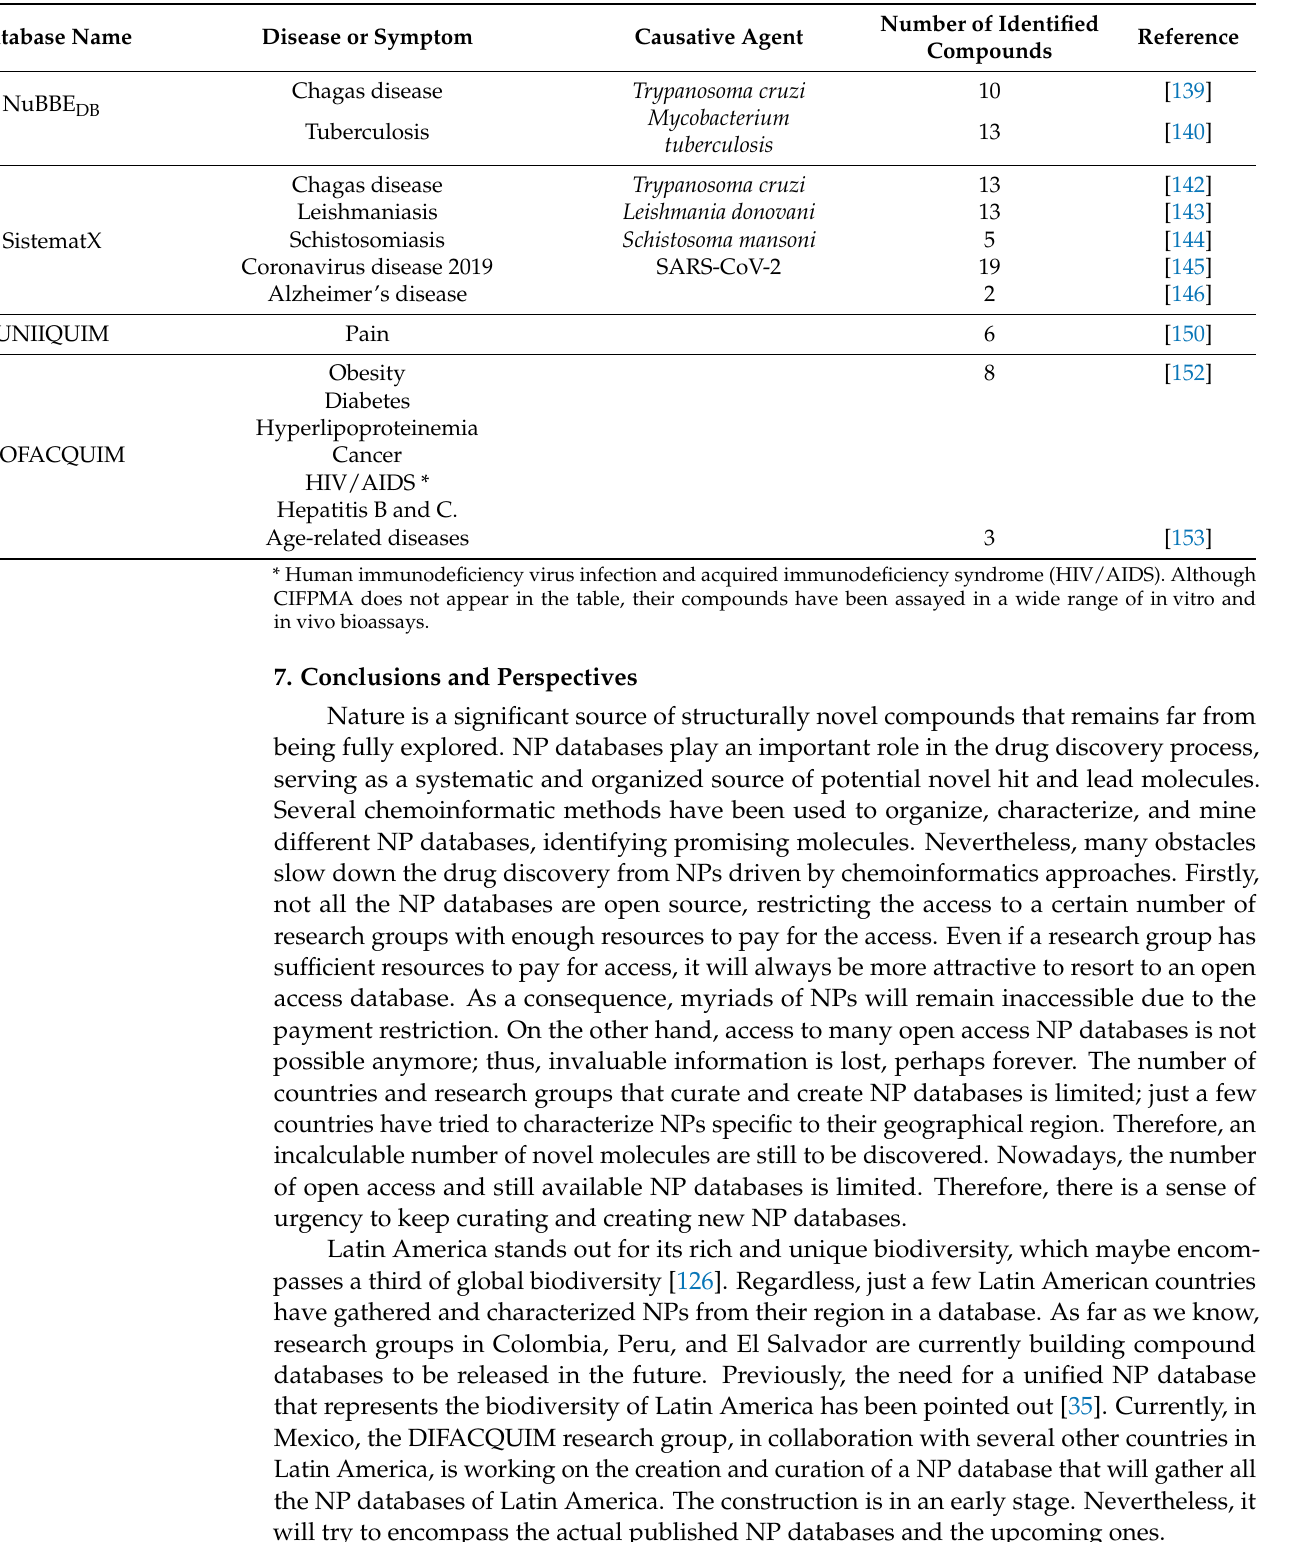
Table 4. Practical applications of the databases of Latin American natural